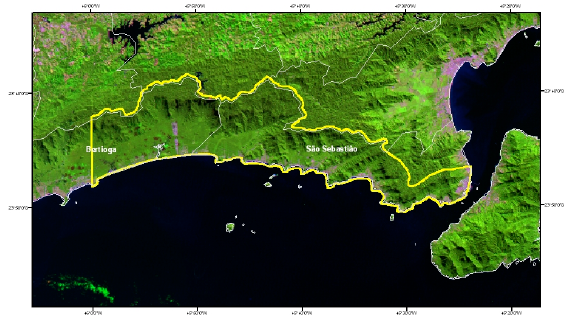
Figure 1: Location of Sudy Area